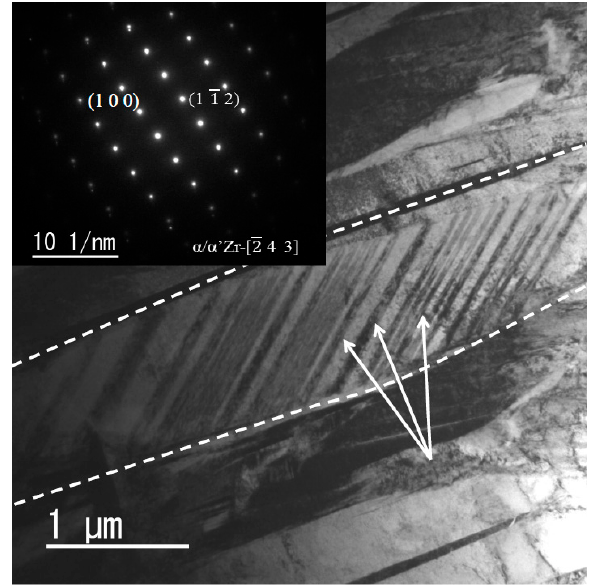
Figure 9. TEM (Transmission Electron Microscope) image of the as-built Zr-1Mo alloys at the energy density of 52.8 J·mm − 3 . The dashed lines indicate grain boundaries of an acicular crystal, and the white arrows indicate twins in the grain.